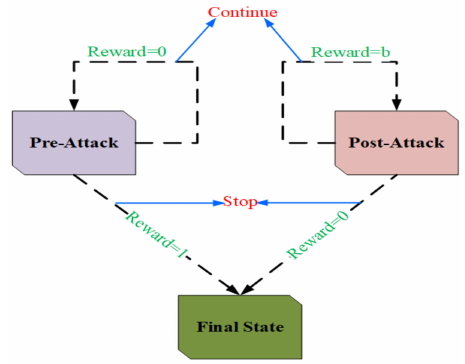
Figure 5. The attack detection